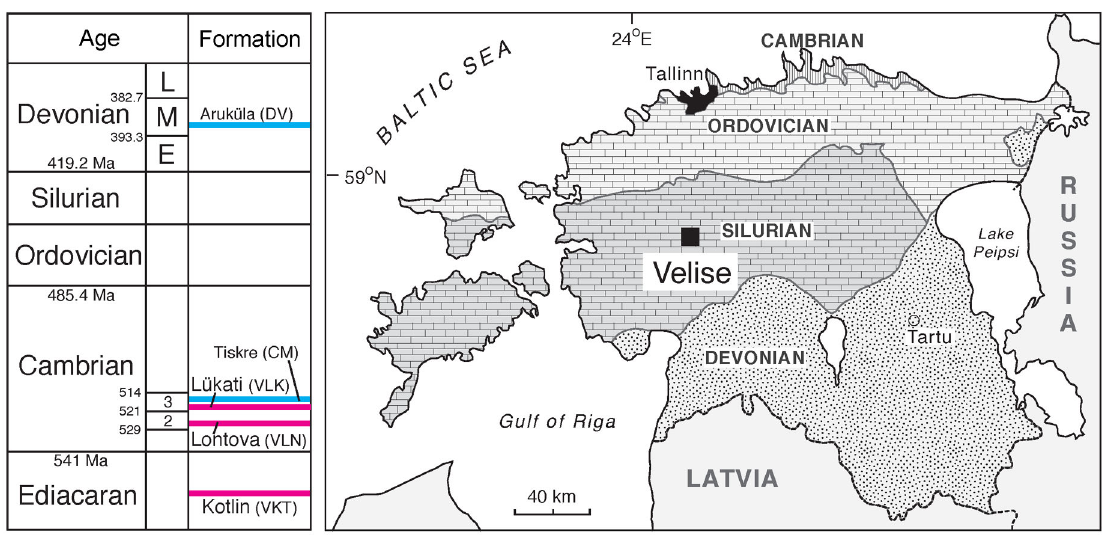
Fig. 1. Ediacaran to Middle Paleozoic stratigraphy in western Estonia with horizons discussed in this article and the location of the Velise-F97 drilling site on a simplified geologic map of Estonia (simplified from Raukas & Teedum(cid:228)e 1997; Nielsen & Schovsbo 2011). Strata of the sandstones analyzed in this study are shown in red and those of Pıldvere et al. (2014) in